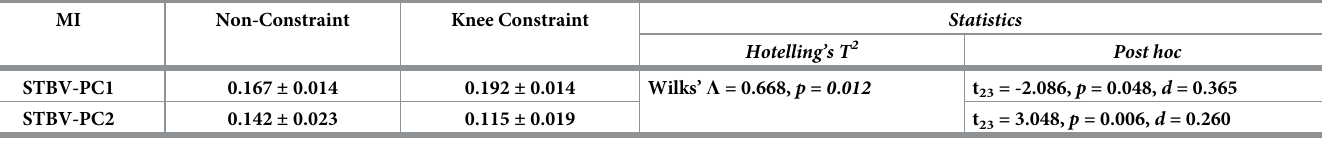
Lower bound for the force-discharge relations: